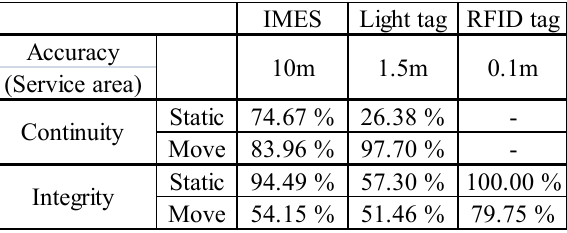
Figure 11. Result from pedestrian tracking using laser scanner data Table 2. Accuracy, integrity and continuity of each sensor in the experimental